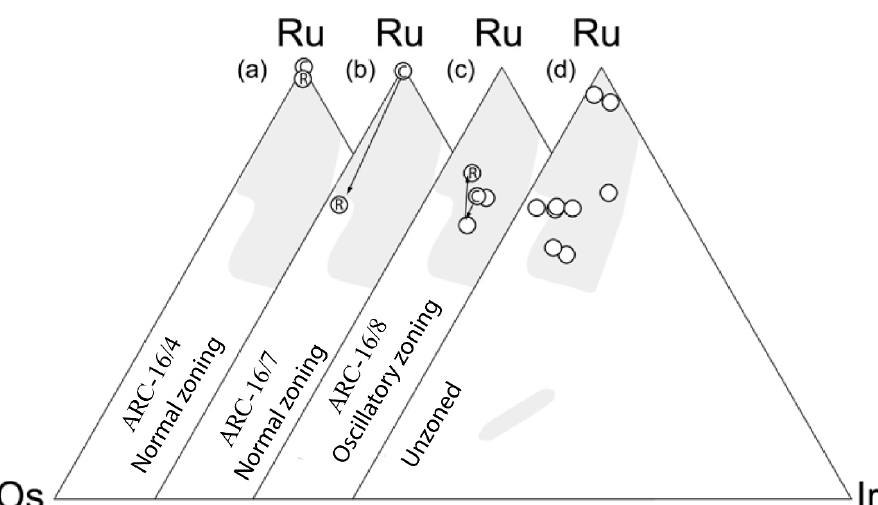
Figure 2. Backscattered electron images of zoned laurites from the Ojén ultramafic Massif. ( a ) euhedral laurite with normal zoning enclosed in chromite (ARC) [21]; ( b , c ) subhedral-euhedral normal zoned laurites with Os-rich cores included within the chromite matrix, (ARC from this study); ( d ) anhedral grain with oscillatory zoning composed of laurite and irarsite (ARC) from this study. Numbers in b, c and d correspond to EPMA results showed in the Table 1.